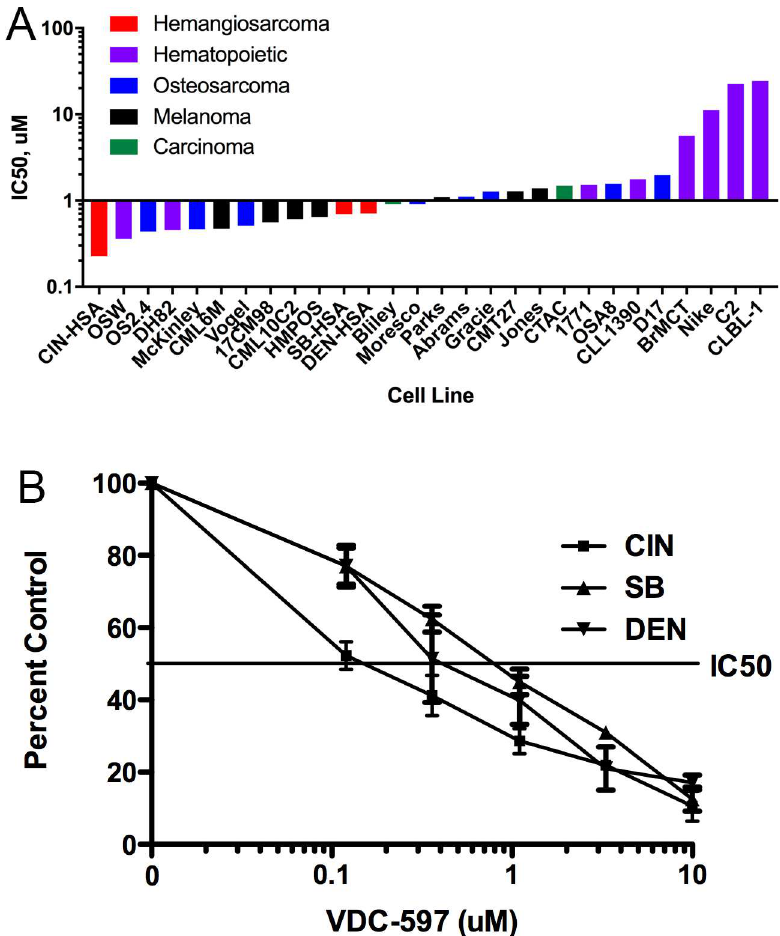
Fig 3. (A)50% Inhibitory concentrations following a 72-hour exposure to VDC-597 in canine tumor cell lines. Canine tumor cells were incubated in C/10 EMEM or C/10 EMEM with various concentrations of VDC-597 for 72 hours, followed by determination of relative viable cell number using a bioreductive fluorometric assay. IC50s were calculated using nonlinear regression, and presented values indicate means from 3 separate experiments. (B). VDC-597 Dose- Dependently Inhibits the Growth of Canine Hemangiosarcoma Cells. Canine HSA cells were exposed to varying concentrations of VDC-597 followed by determination of relative viable cell number as above. Calculated IC50s were 0.23, 0.69 and 0.71 uM for CIN-, SB-, and DEN-HSA respectively. Results shown indicate means of 3 separate experiments. Error bars indicate standard error measurements.